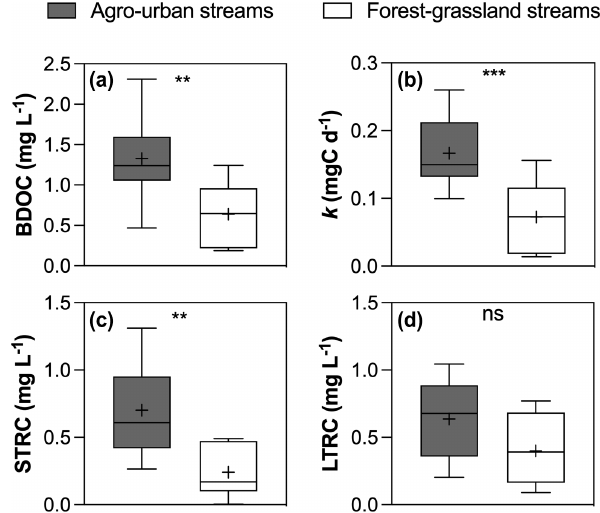
Figure 5. Boxplots of (a) BDOC concentrations, (b) constant de- cay k , (c) STRC and (d) LTRC pools in agro-urban (grey) and forest–grassland (white) streams. The box represents the first and third quartile, the horizontal line corresponds to the median, the cross corresponds to the average, and the error bars correspond to the maximum and minimum. Mann–Whitney unpaired t tests were used to test for statistical differences: ns represents not significant, ∗= p < 0.05, ∗∗= p < 0.01, ∗∗∗= p < 0.001, ∗∗∗∗= p < 0.0001.